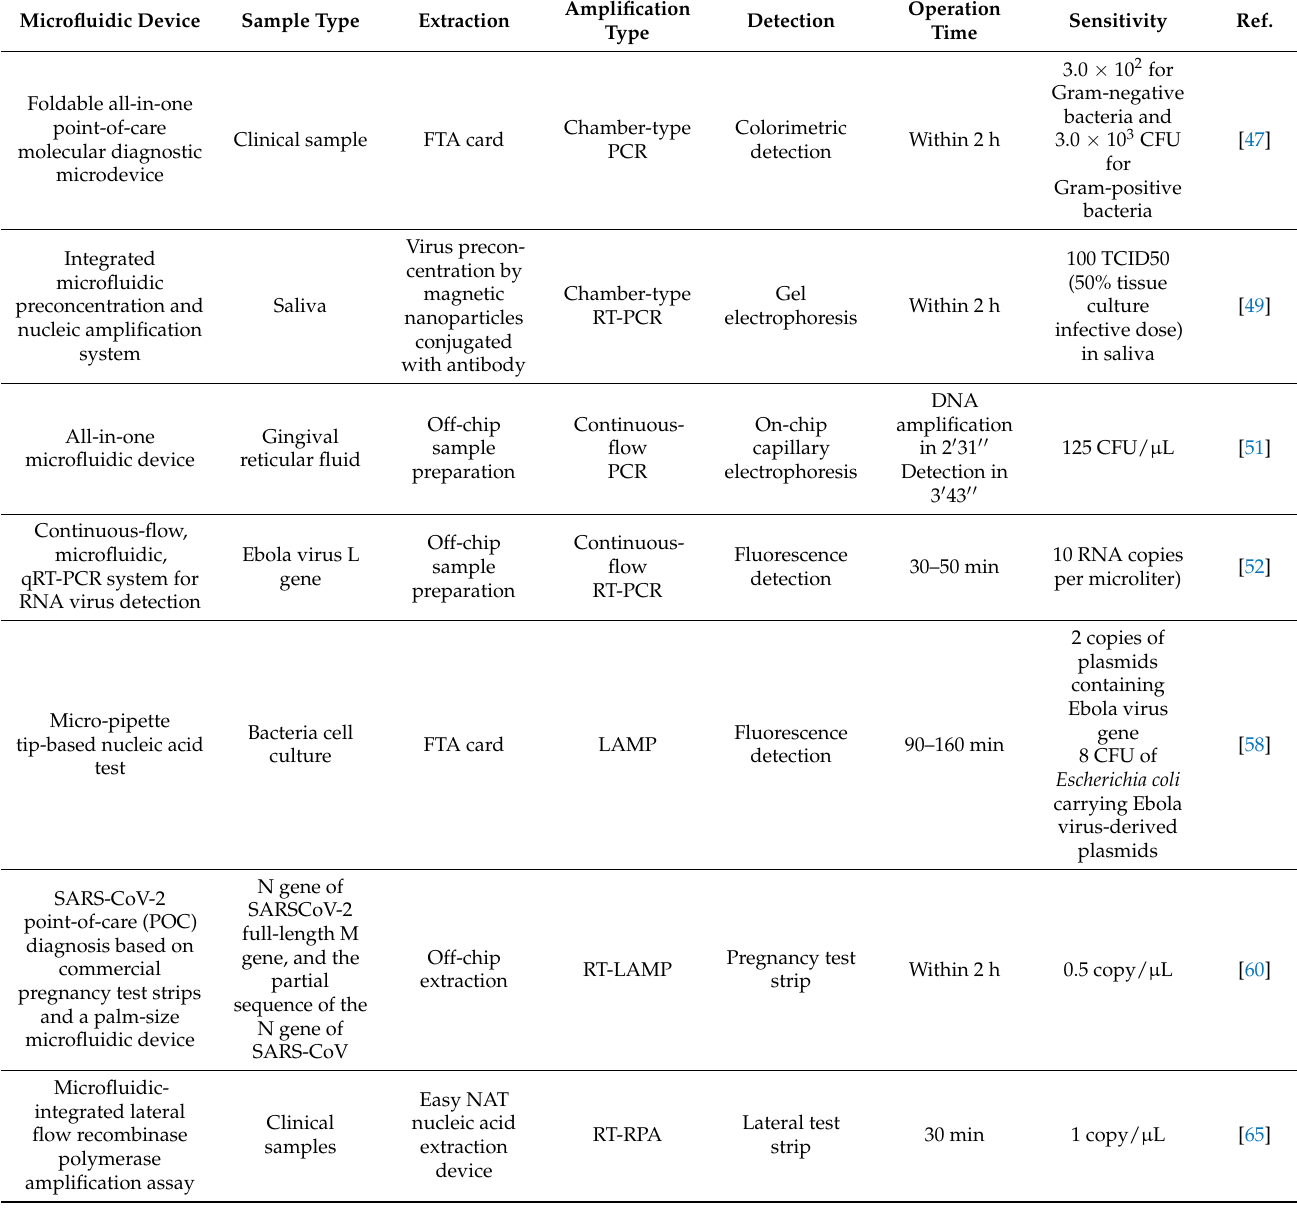
Table 2. Features of some nucleic acid amplification-based microfluidic